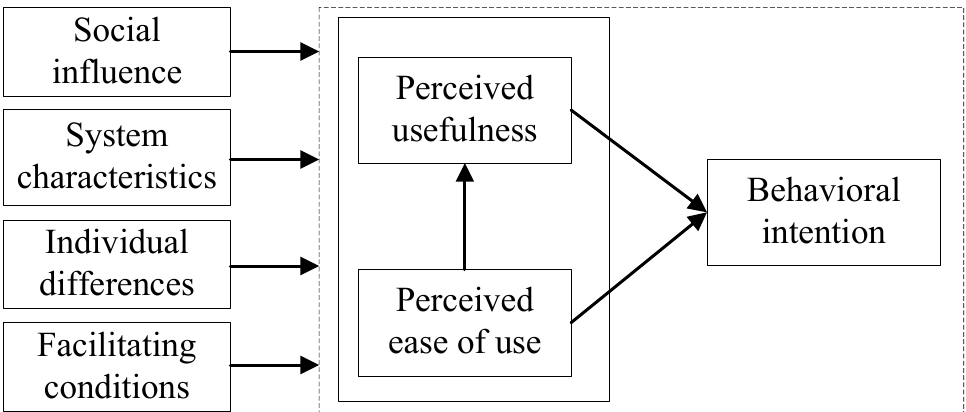
Figure 1. The theoretical framework of the Technology Acceptance Model